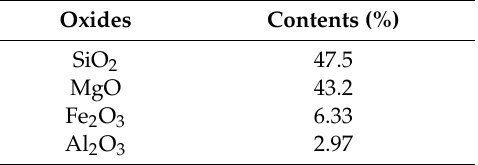
Table 1. X-ray fluorescence analysis results of the milled serpentine particle.